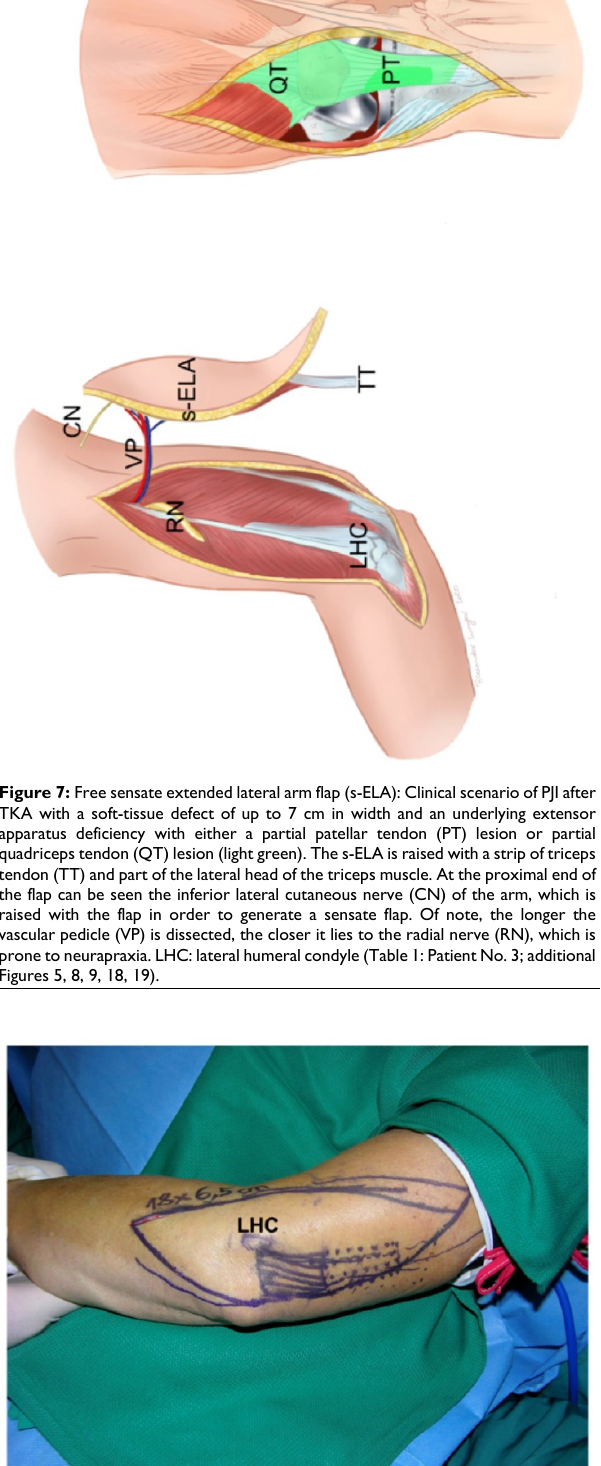
http://www.jbji.net